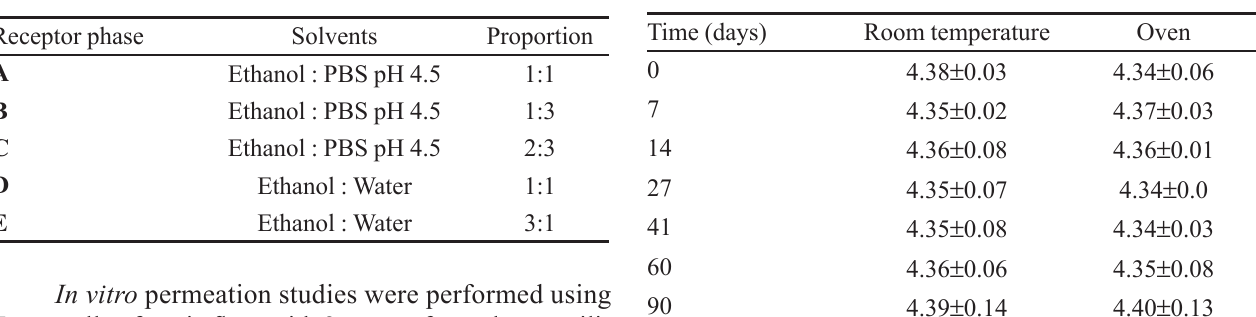
TABLE II - pH values through 365 days (mean ± SD, n =